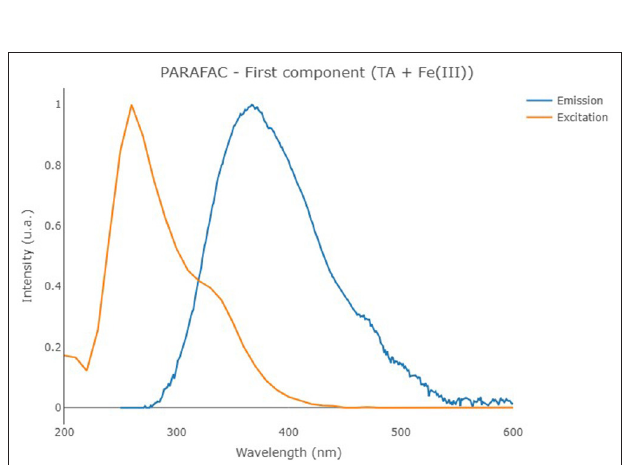
FIGURE 6 | Excitation (orange line) and emission (blue line) profiles of the first component of the PARAFAC model that was built on the solutions containing TA with Fe(III).